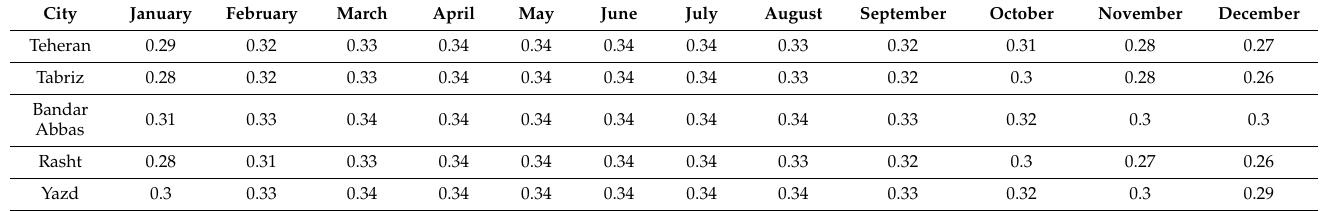
Table 9. Actual efficiency of the Stirling engine installed in the selected cities.